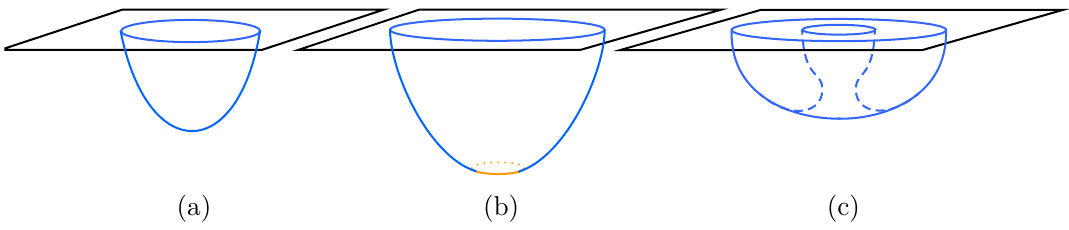
Figure 7. Three types of embeddings found when solving the equation of motion found when computing entanglement entropy on disks. When the radius of the disk is sufficiently small, the embedding does not reach the IR part of the geometry (a). For large values of the radius of the disk, the embedding reaches the end-of-space (b). Additionally, when considering mutual information between disks, embeddings like (c) should be taken into